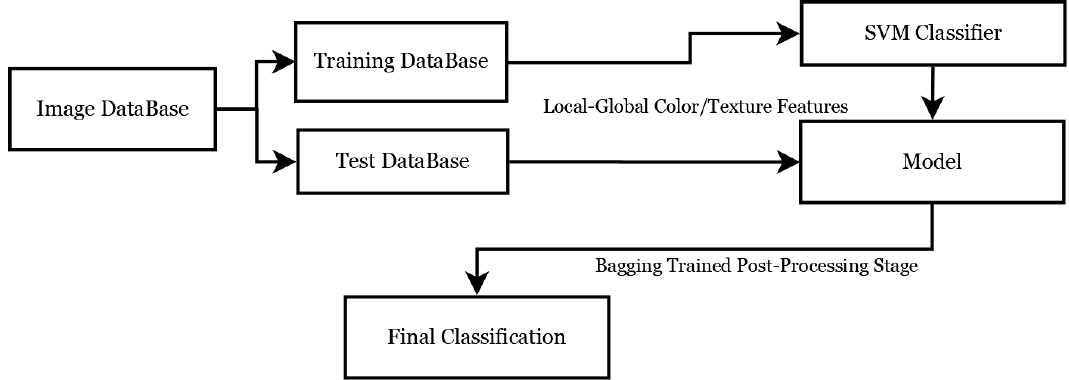
Figure 1. Block diagram of the proposed method.